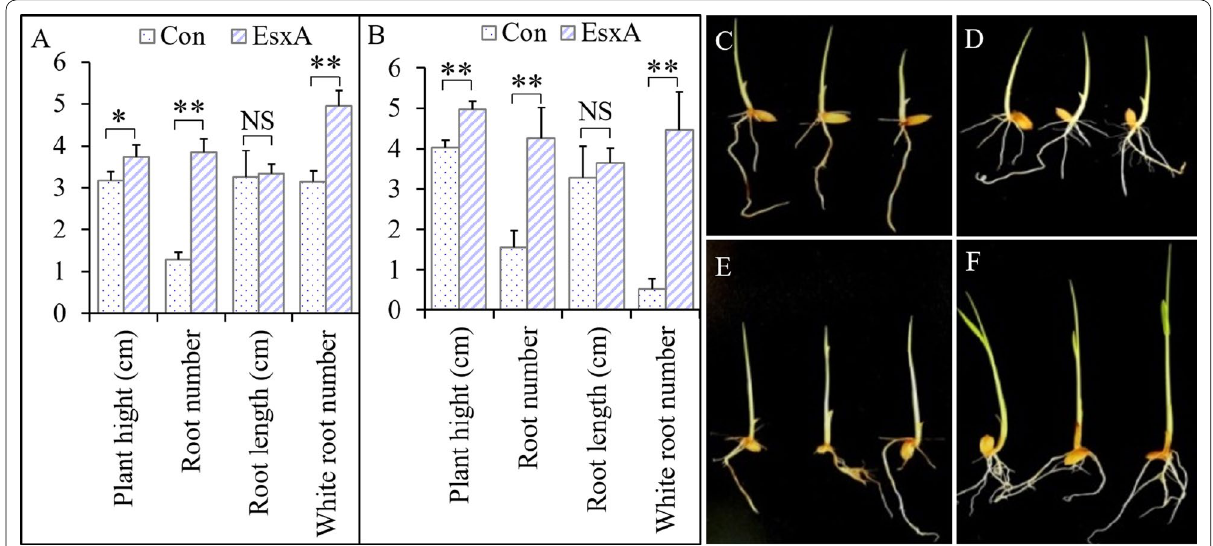
Fig. 3 Effects of protein elicitor EsxA on the growth and performances of rice udner seedling blight ( Fusarium oxysporum ) stress (seedling-spraying treatment, 7 days). A , C , and D : 48 h after the EsxA treatment; B , E , and F : 7 days after the inoculation with Fusarium oxysporum , with C and D representing control (Con) seedlings (without EsxA) and E and F representing seedlings sprayed with EsxA. The number of roots was determined based on roots longer than 1 cm; the number of white roots includes roots shorter than 1 cm (* P < 0.05, ** P <